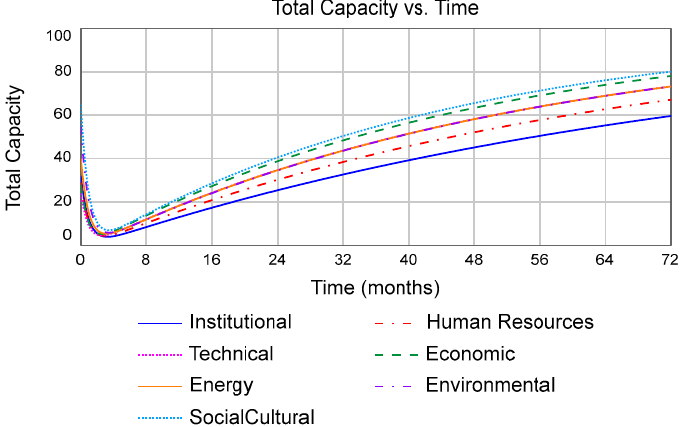
Figure 13. Variation of the seven categories of capacity over 72 months (six years).